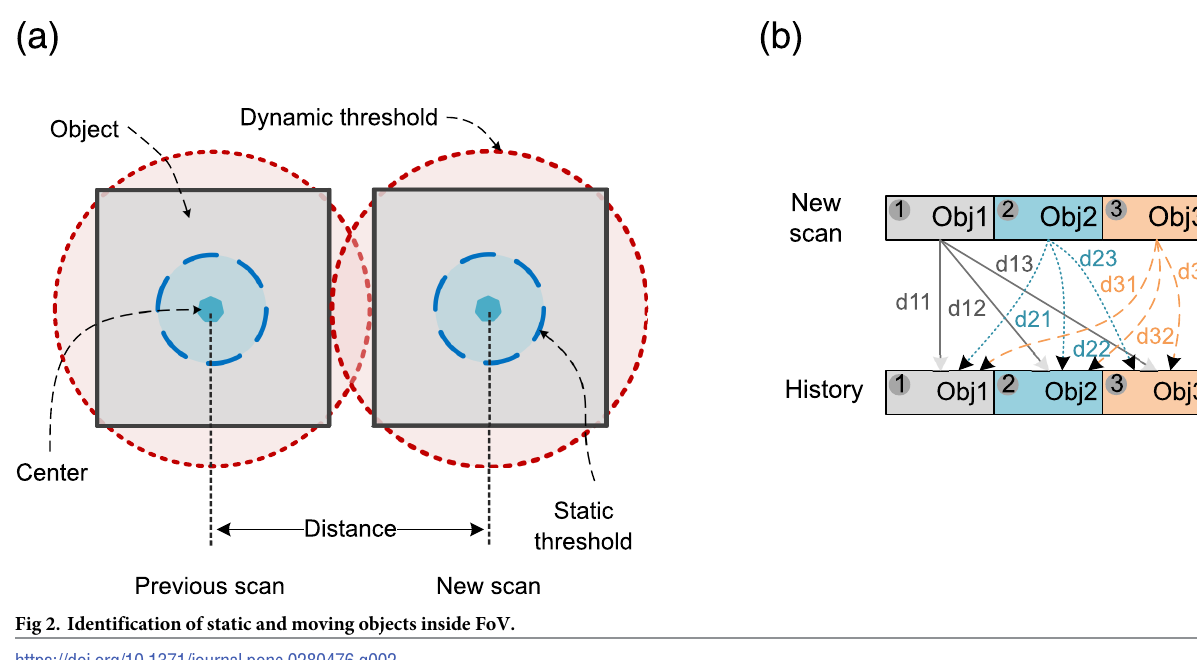
Fig 2. Identification of static and moving objects inside